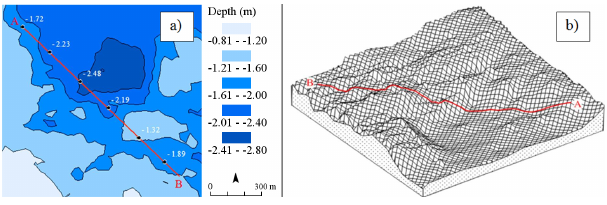
Figure 8. (a) Profile display, contour map. (b) Profile display, three- dimensional model.